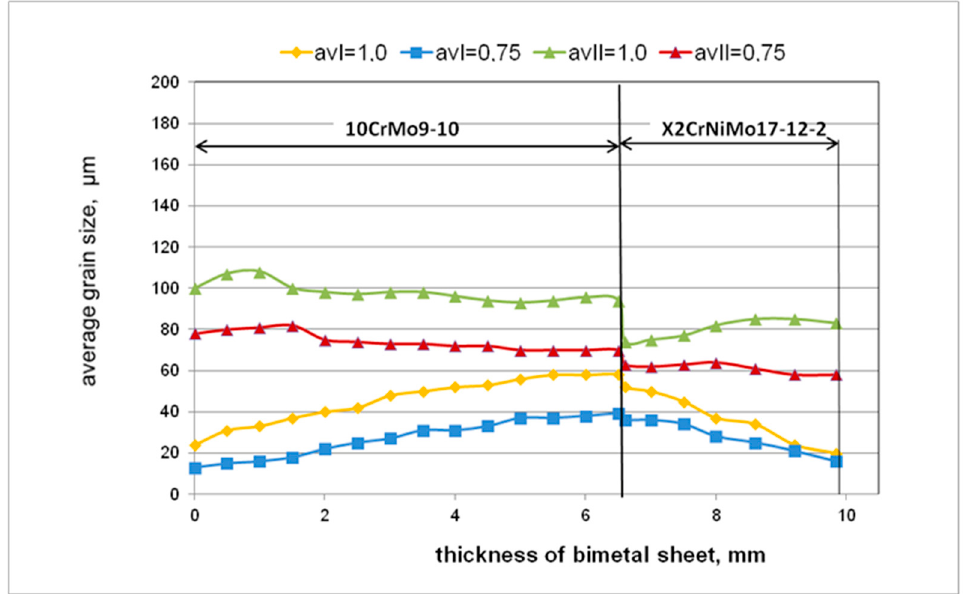
Figure 11. The distribution of the average grain size at the height of the bimetallic sheet metals for two cooling variants (I and II) of the samples after symmetrical a v = 1.0 and the asymmetric rolling process a v = 0.75.